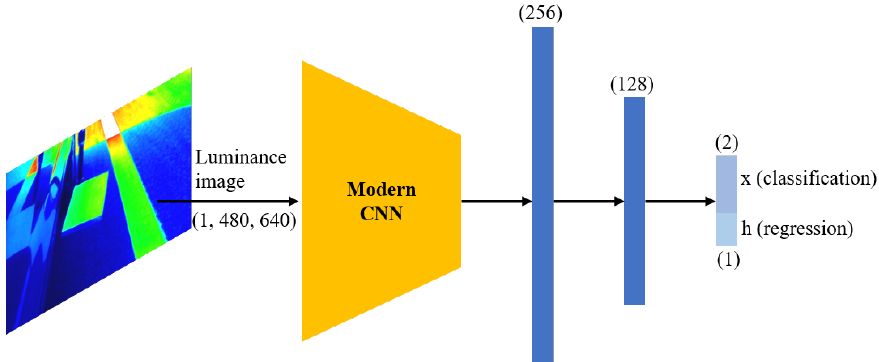
Figure 6. Neural network architecture of convolutional neural network (CNN) model for classification and regression. Pretrained models, i.e., Resnet-18 [12], VGG-16 [13], Alexnet [6], Mobilenet [14], and Shufflenet [15], were employed as